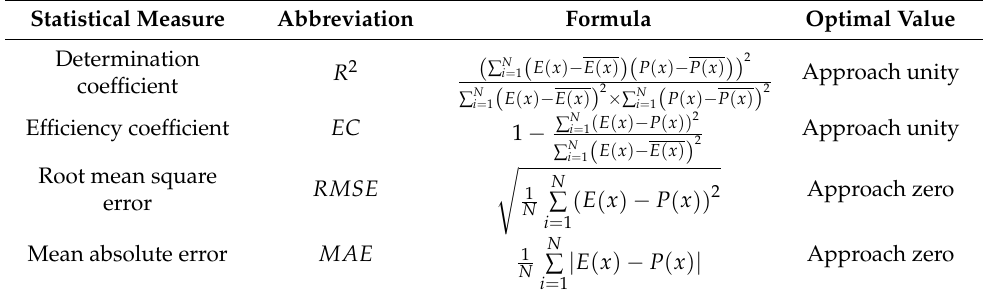
Table 2. Statistical measures used for model evaluation